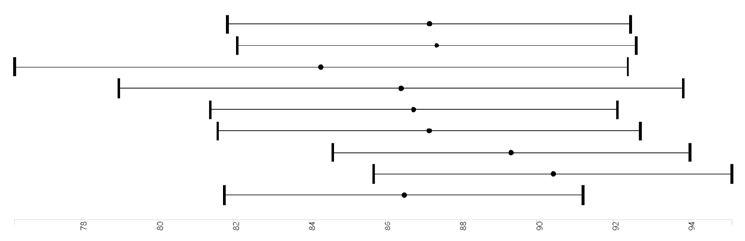
Figure 5. Income e ff ects across Figure 5. Income effects across groups.